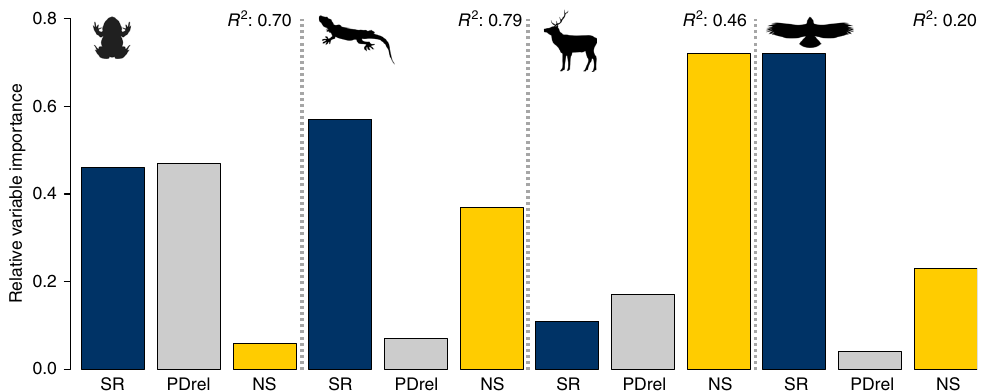
Fig. 4 Relative variable importance of macroecological characteristics. Variable importance of species richness (SR), relative phylogenetic diversity (PDrel), and niche size (NS) in explaining phylo- ß in environmental space is given for amphibians, squamates, mammals, and birds. R 2 represents the model fi t of a standardized linear regression to explain phylo- ß by means of standardized SR, PDrel, and NS (linear and quadratic terms). Relative variable importance values are re-scaled to add up to sum of 1.0. Silhouette images were taken unchanged from phylopic.org, courtesy of Pedro de Siracusa (amphibians), Ghedo and T. Michael Keesey (squamates) both available under CC BY-SA 3.0 (creativecommons.org/licenses/by-sa/3.0/), Steven Traver (mammals) available under CC0 1.0 (creativecommons.org/publicdomain/zero/1.0/), and Shyamal (birds) available under CC BY 3.0 (creativecommons.org/